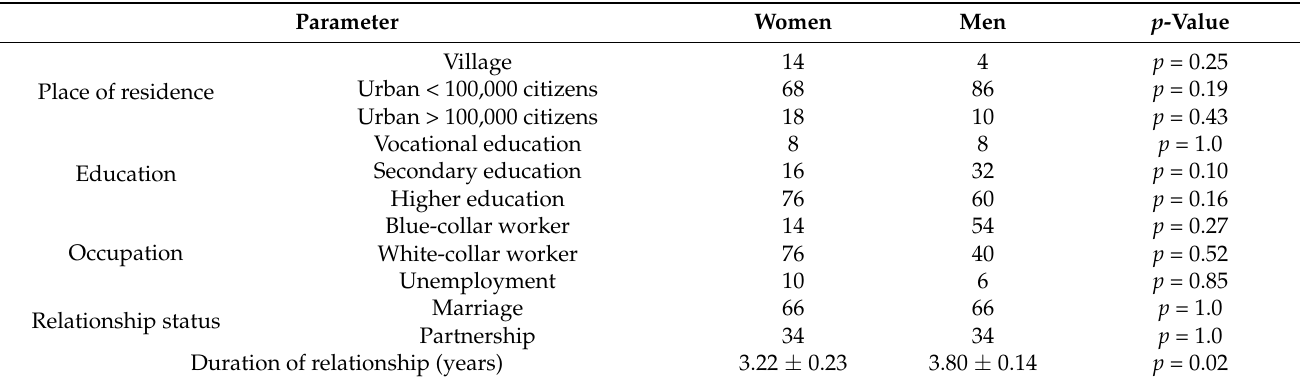
Table 2. Characteristics of the study group based on answers to questions in metrics.